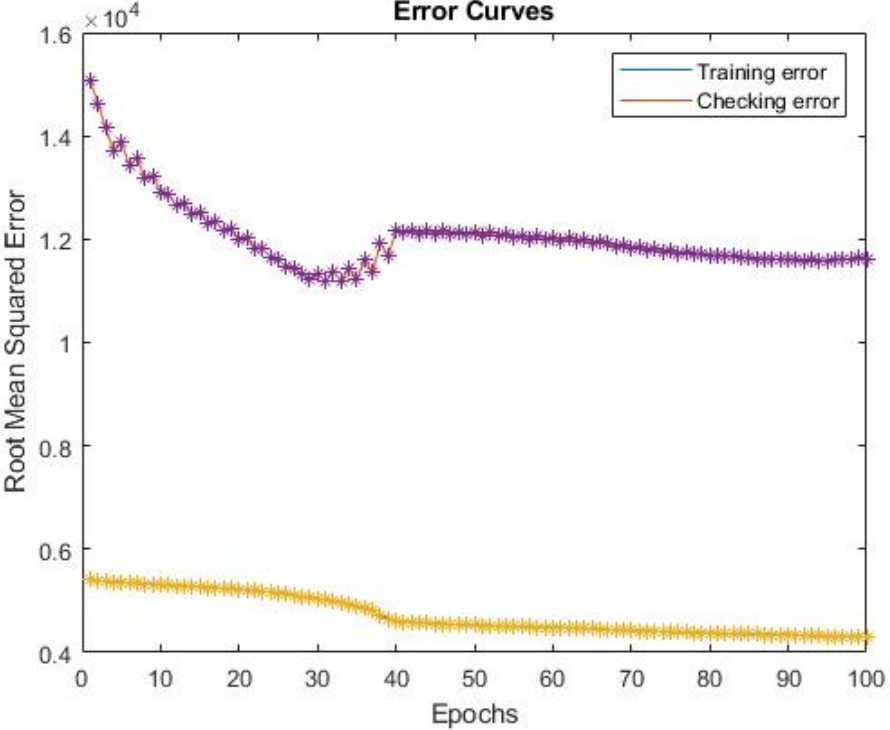
Figure 7. Error measurement for training and validation for demand forecasting.